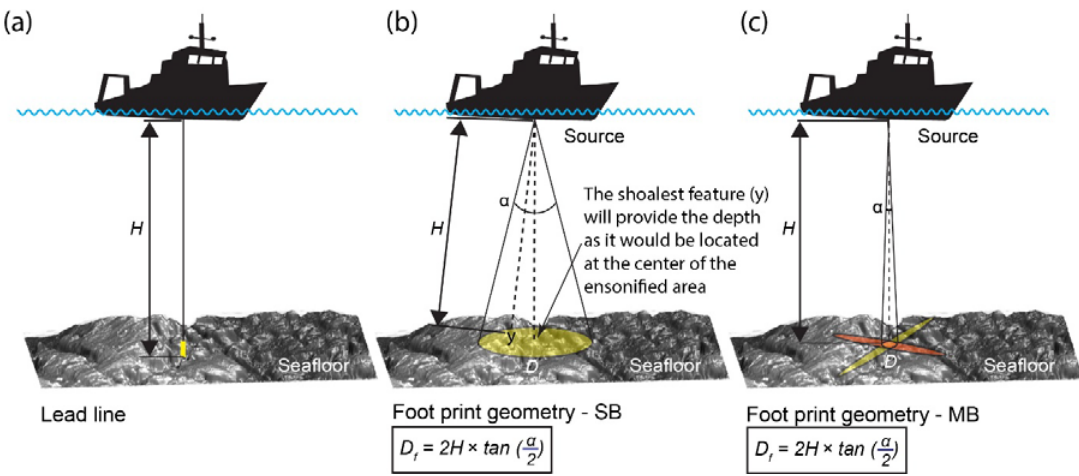
Figure 2. The mapped area of the seafloor (ensonified area) using different methods. ( a ) Lead line. ( b ) Single-beam echo-sounder (SB). ( c ) Multibeam echo-sounder (MB).